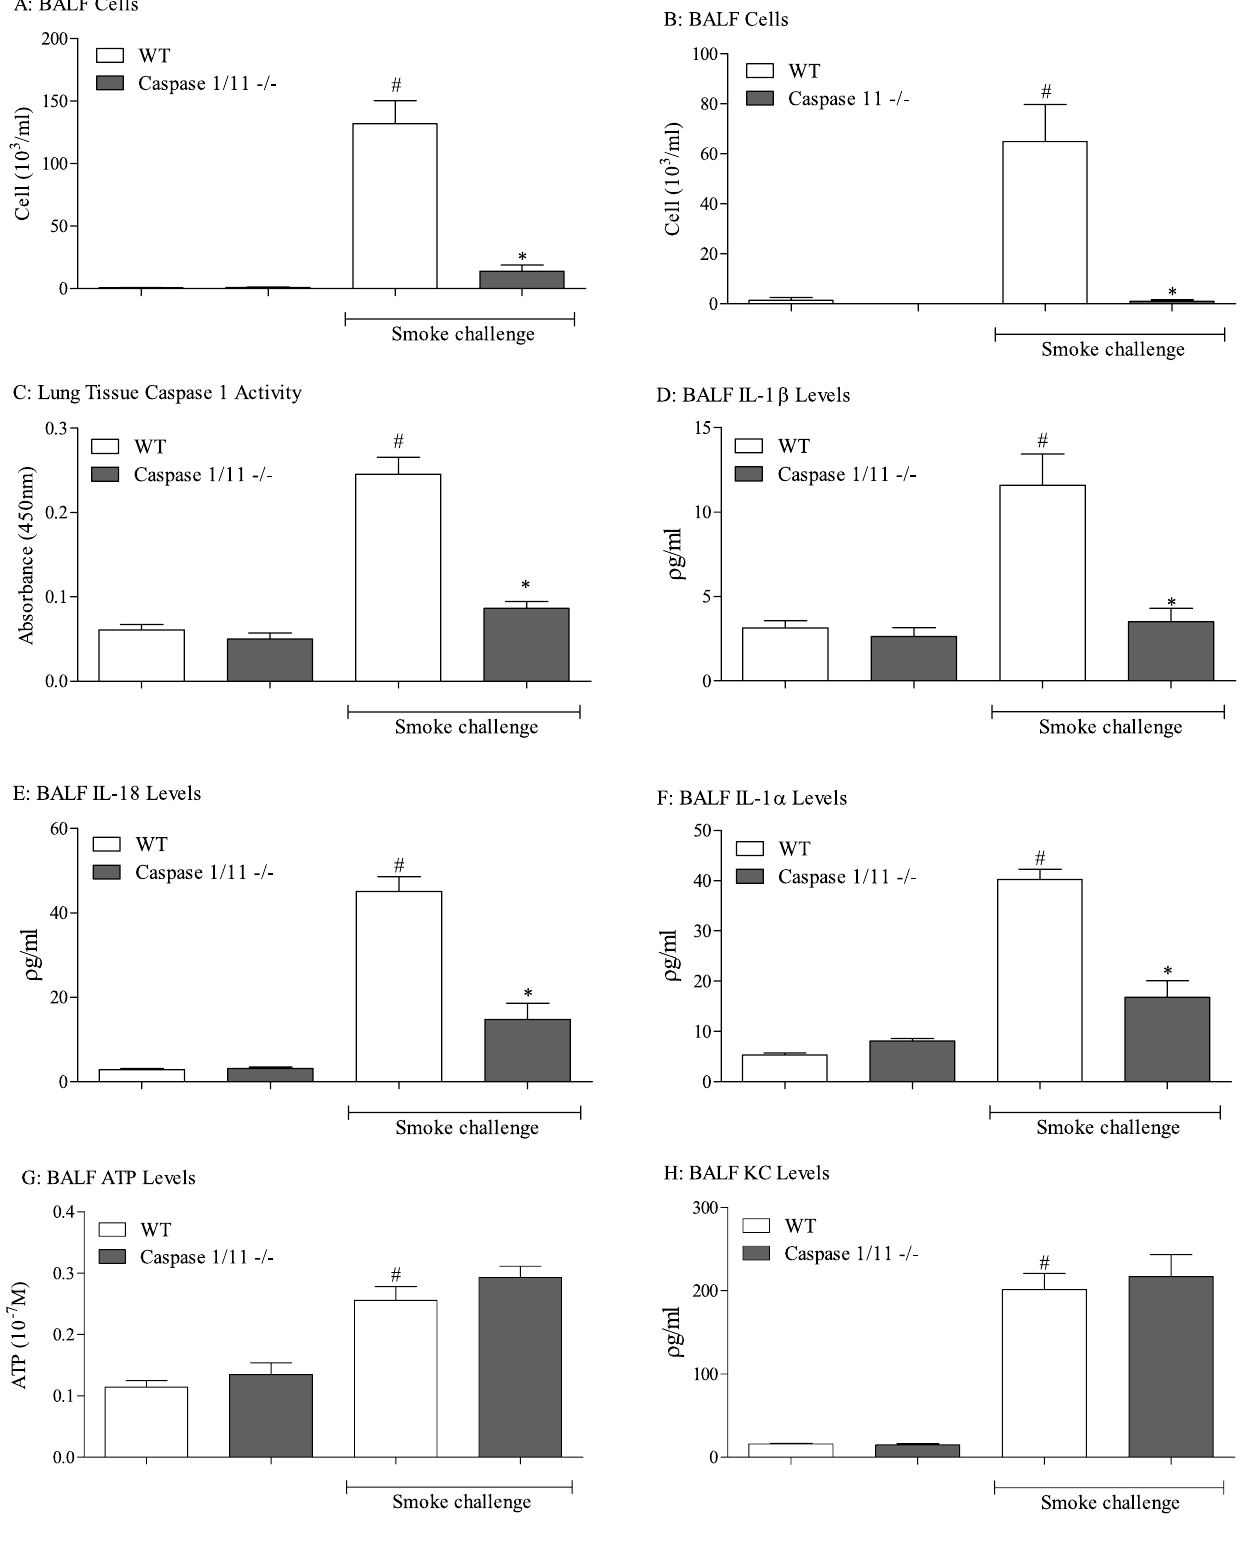
Figure 3. Role of the caspase 1 and 11 in CS-driven model. Caspase 1/11 or caspase 11 -/- mice were exposed to CS or room air (control) twice daily for 3 consecutive days alongside wild-type controls. BALF and lung tissue was collected 24 hours after the last exposure for measurement of neutrophilia (A – caspase 1/11 -/-, B – caspase 11-/-). Figures C to H depicts the levels of caspase 1 activity (C), IL-1 b (D), IL-18 (E), IL-1 a (F), ATP (G) and KC (H). Data are represented as mean 6 S.E.M. for n=8 animals in each group. Statistical significance was determined using Mann-Whitney U test. # =P , 0.05, denoting a significant difference between the smoke exposed and air exposed wild-type groups; * =P , 0.05, denoting a significant difference between the smoke exposed knock-outs and wild-types. doi:10.1371/journal.pone.0112829.g003 PLOS ONE |